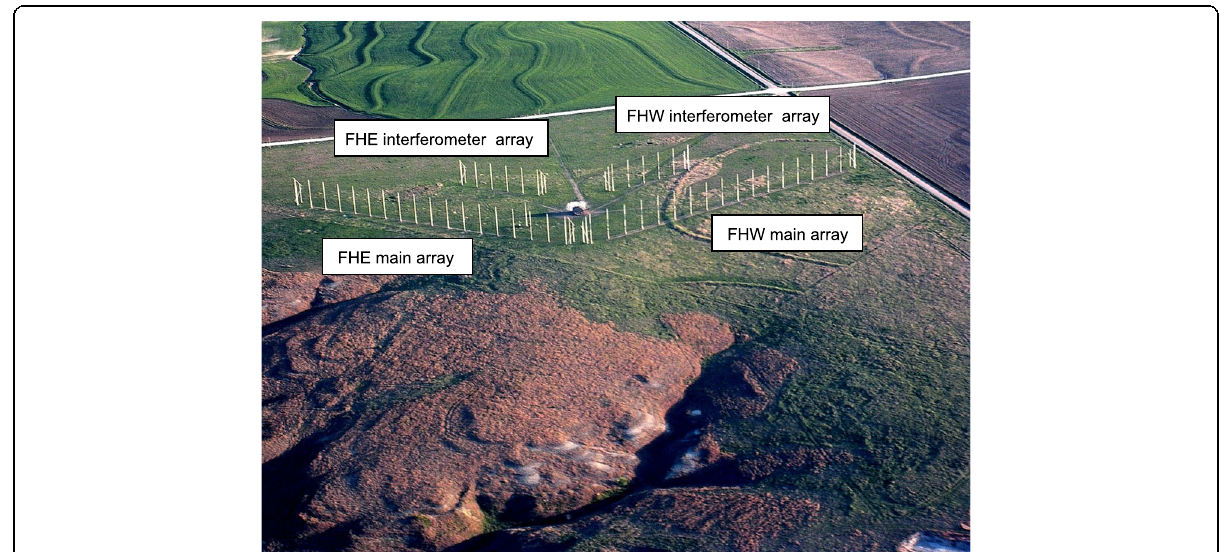
Fig. 2 Photo of the Fort Hays East and West radar antennas and radar equipment